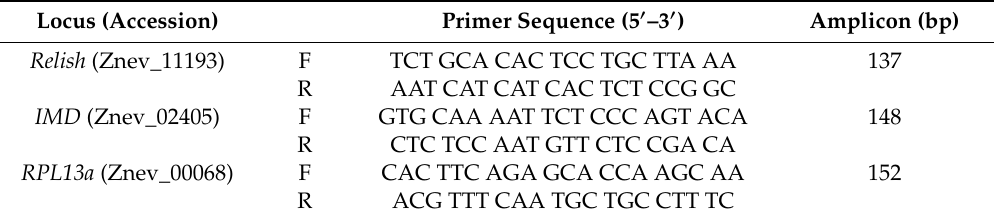
Table 2. Primer sequences used to assess immune gene transcription. Locus (Accession) Primer Sequence (5 (cid:48) –3 (cid:48)